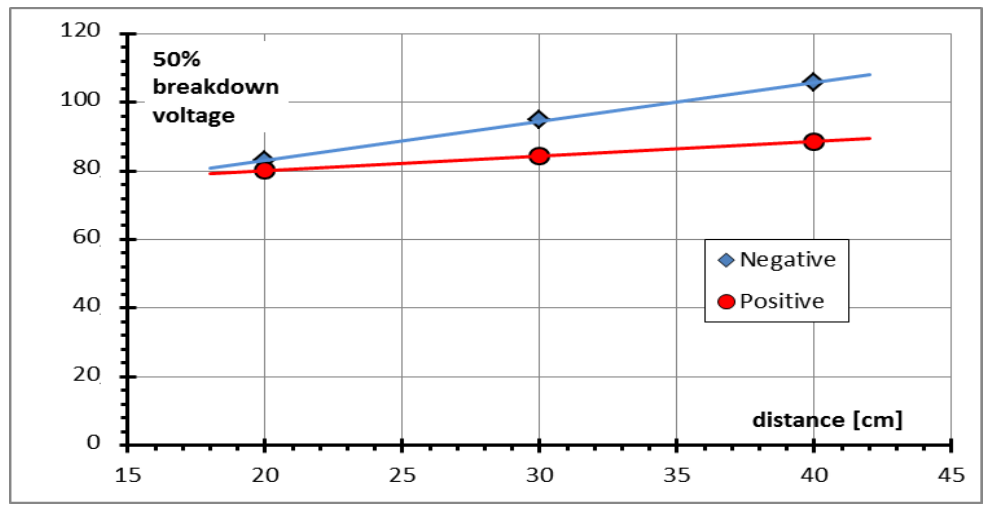
Figure 10. Measurement of 50% voltage breakdown for MCA in terms of positive and negative polarity of applied lightning impulse voltage.